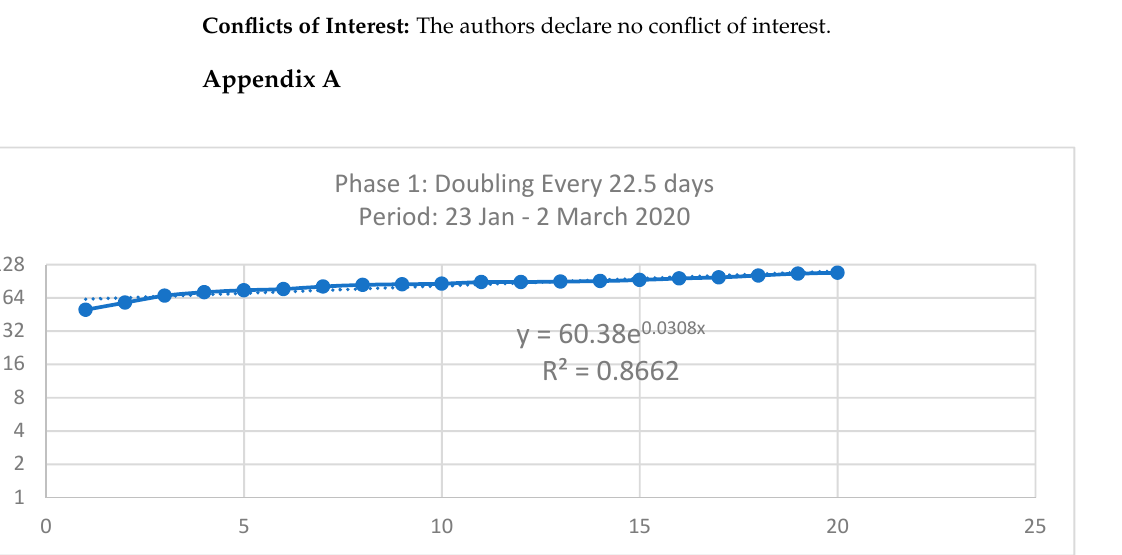
Figure A1. Logarithmic scale. Doubling time calculated based on a 20-day period in Phase 1. Data retrieved from the